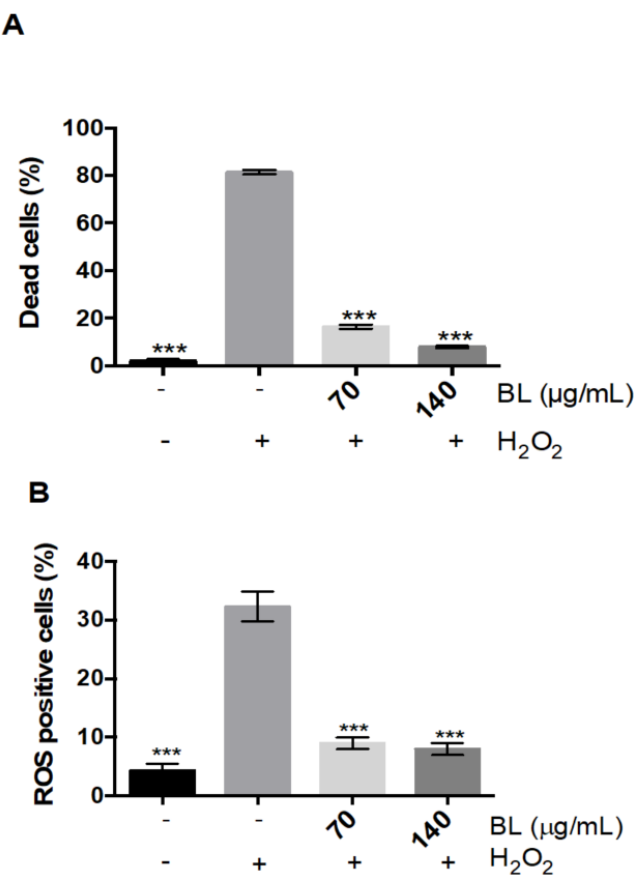
Figure 1. A. lappa leaves extract protects human myoblasts from induced oxidative stress. Cell death ( A ) and ROS ( B ) quantification (percentage of all cells) in human myoblasts that were incubated with the A. lappa leaves extract (BL) at indicated concentrations prior to incubation with H 2 O 2 . All data represent the means ± SD of three independent experiments; p < 0.001 (***) compared with H 2 O 2 (one-way ANOVA).